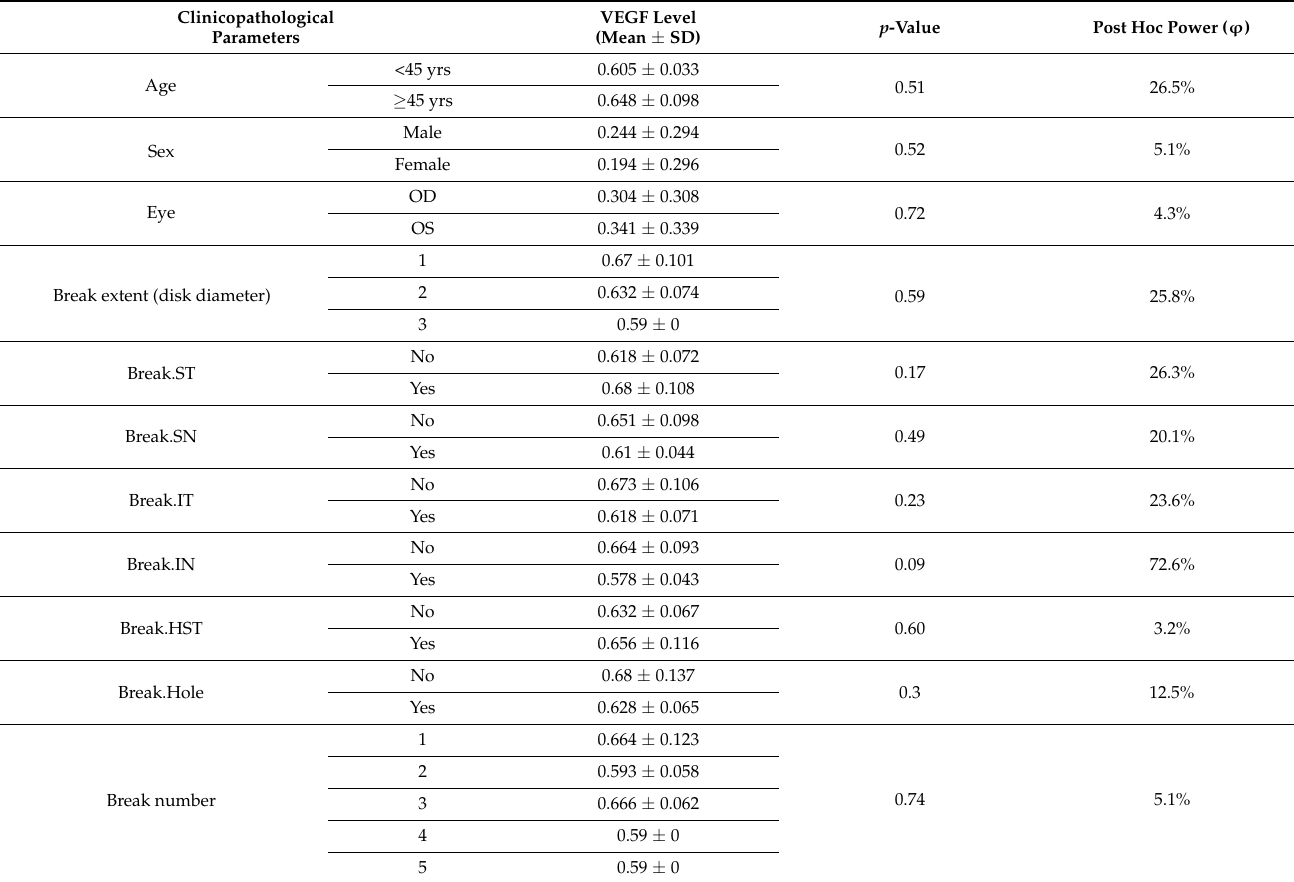
Table 2. VEGF levels relation to break location, extension, and number in the RRD vitrectomy samples. Data shown as mean ± SD were analyzed by Mann–Whitney U test.